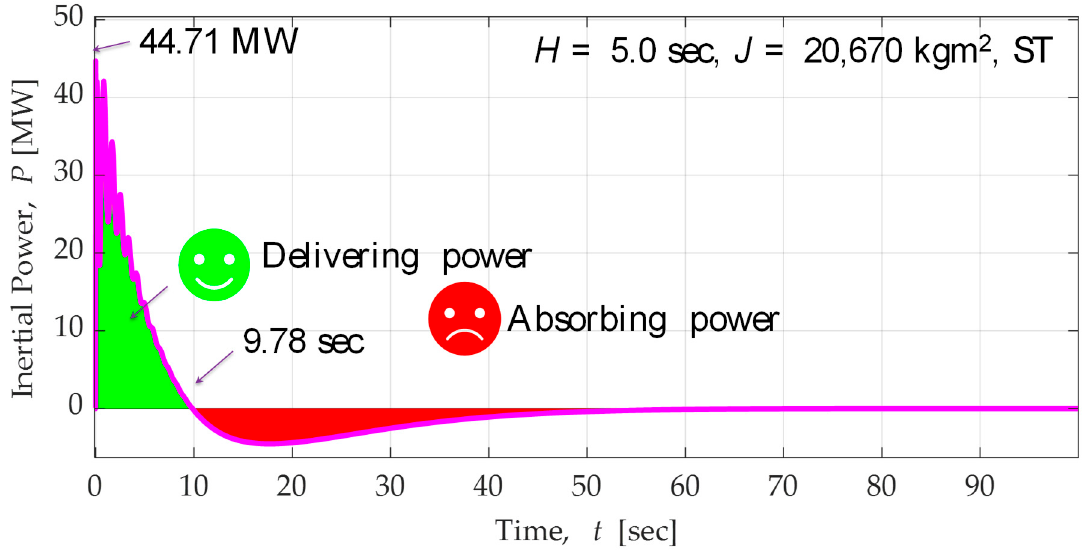
Figure 11. Inertial power during the under-frequency event shown in Figure 9: H = 5.0 s, 255 MVA. As stated before, the rotational inertia is located at the synchronous generator rotors, and they are spread throughout the electrical power system; during a frequency event, each synchronous machine directly connected to the power system will provide an inertial power contribution that depends on the rotational inertia and other factors (e.g., synchronising coefficients, etc.). During a power imbalance (independently of the size), the system’s frequency is not unique; in fact, each synchronous generator experiences changes in the rotational speed to accommodate the new operating status, and the frequency produced by each generator will be different. The frequency of the inertia centre ( f CoI ) as presented in (2) is a very important indicator used to assess the frequency response of a multi-machine power system; it represents an averaged frequency where the averaging weights are the rotational inertia of the synchronous generators involved in the frequency response. To illustrate the role of the rotational inertia and the implications of the centre of in the system frequency response of a multi-machine power system, an experiment considering a three-control area power system is used. Figure 12 shows the block diagram of one of the three identical interconnected control areas, and the complete set of parameters are shown in Table